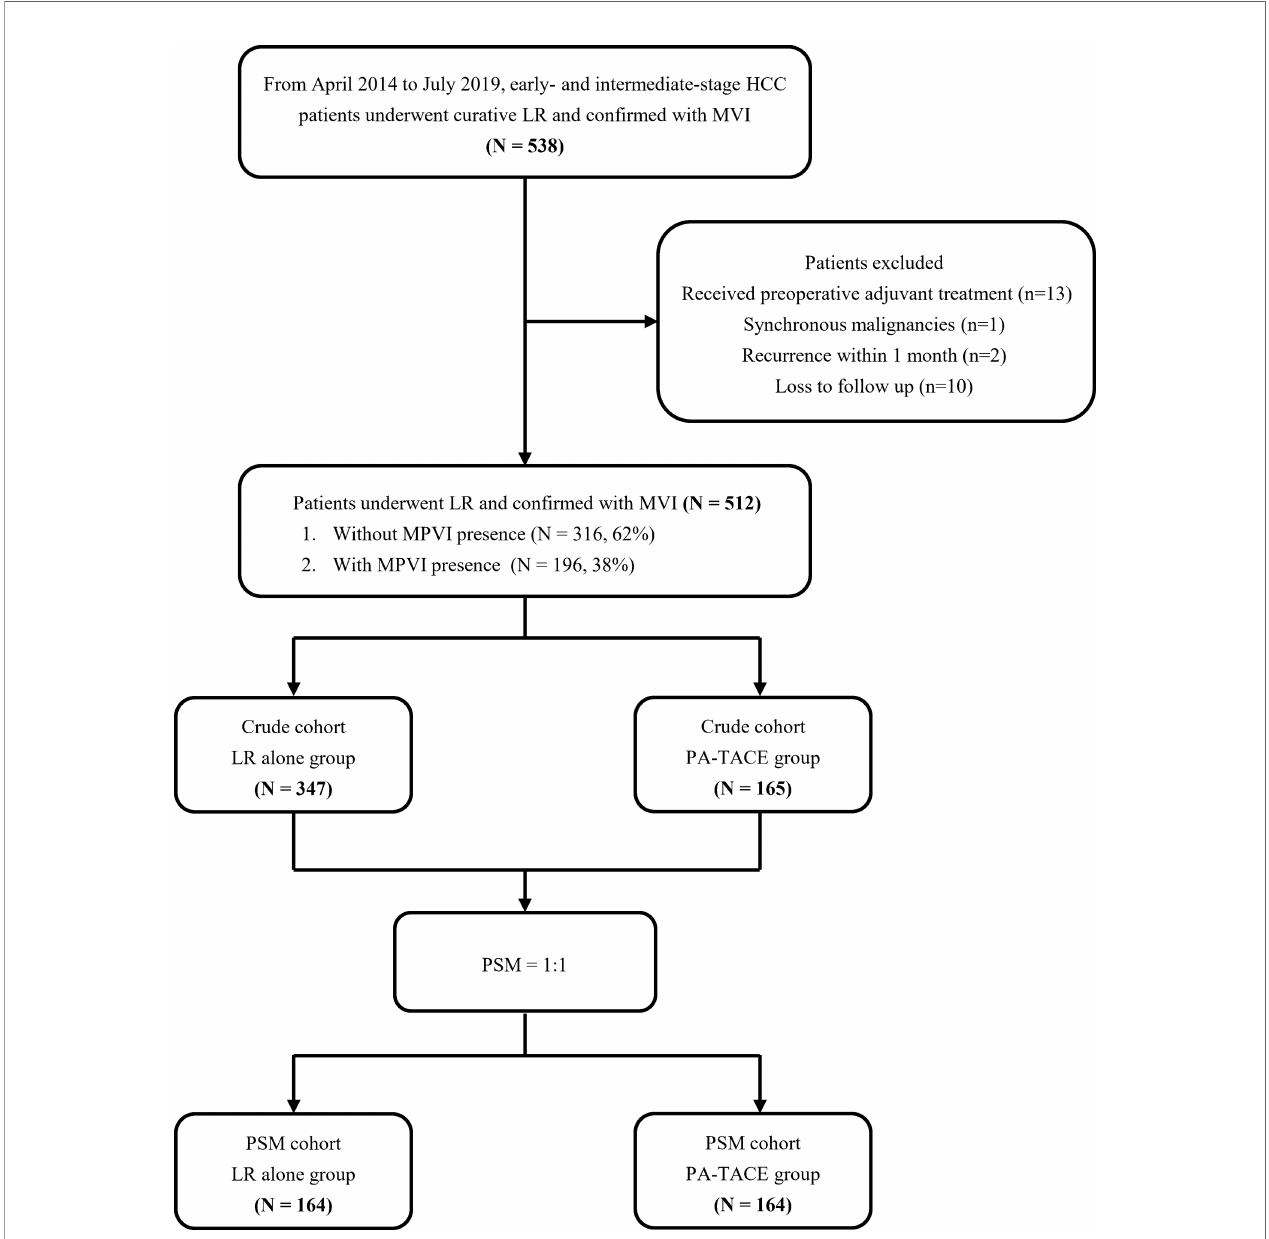
FIGURE 1 | Diagram of patient